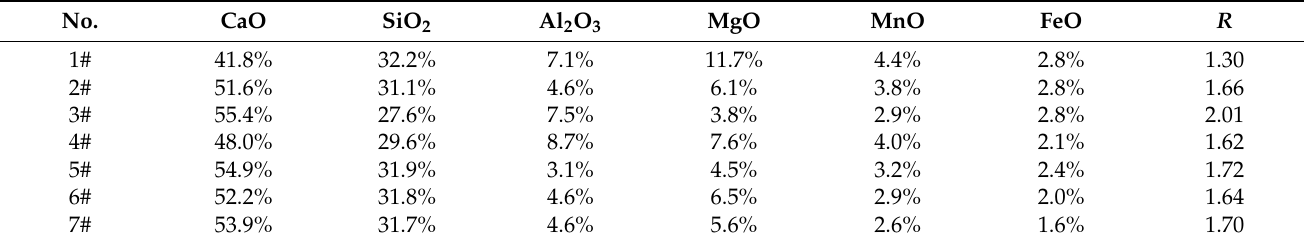
Table 2. Slag compositions in different tests after smelting,